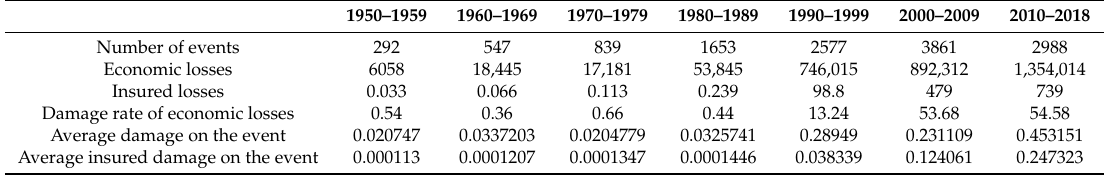
Table 2. Analysis of 10-year periods of natural disaster impacts (USD billion in